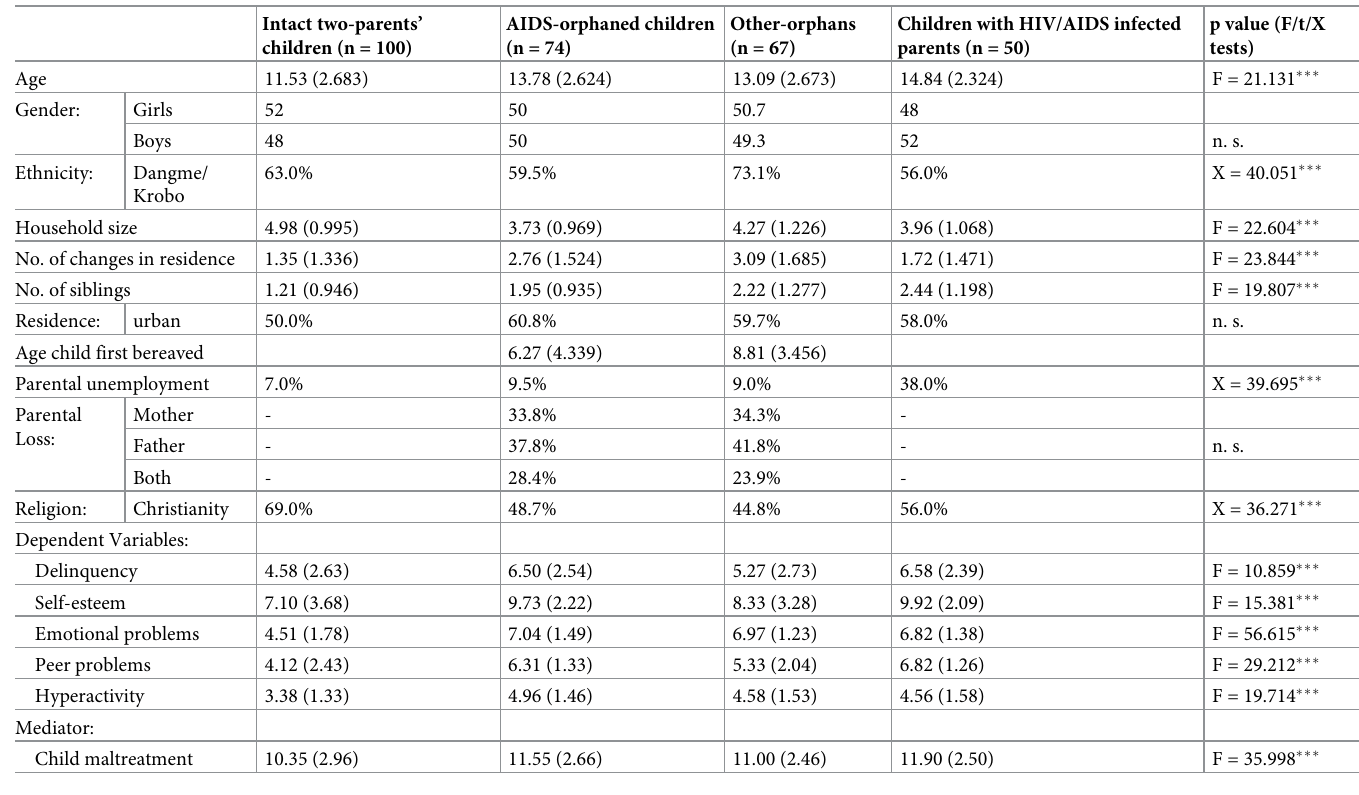
Table 1. Descriptive statistics of the